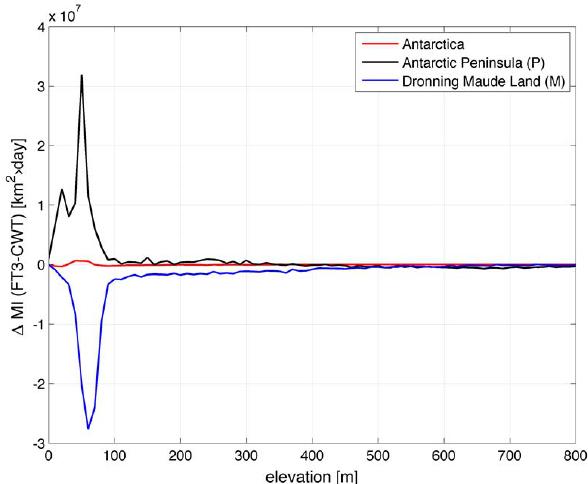
Fig. 7. An analysis of the difference in melting index ( 1 MI = MI FT3 − MI CWT ) estimates from the FT3 and CWT meth- ods at a range of elevations for the entire Antarctic continent (red line) as well as the Antarctic Peninsula (black line) and Dronning Maud Land (blue line).